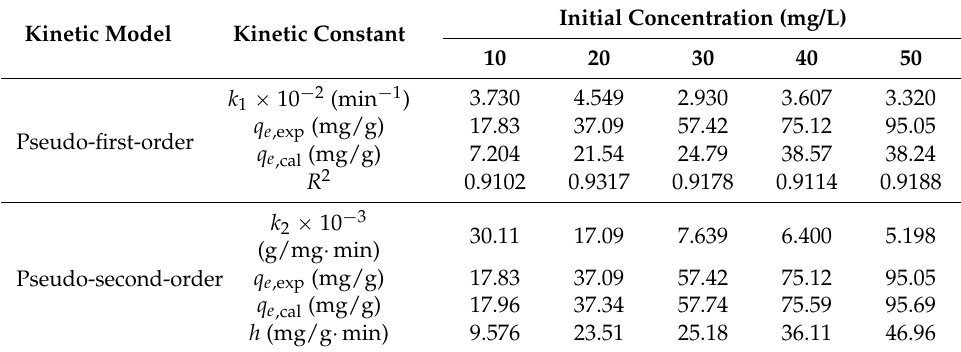
Table 3. Kinetic Constants of Pseudo-First-Order and Pseudo-Second-Order Kinetic Models. Kinetic